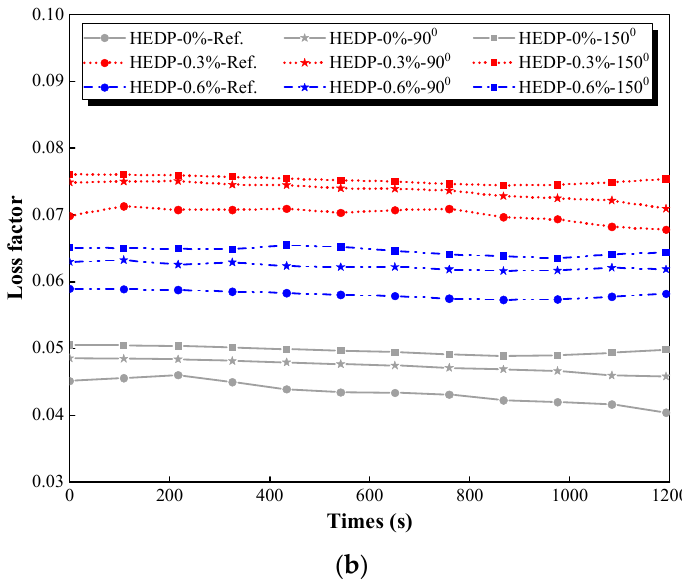
Figure 5. Loss factor of 28d FR-AASC. ( a ) Frequency (0.5–2.5Hz), ( b ) Time (0–1200s).